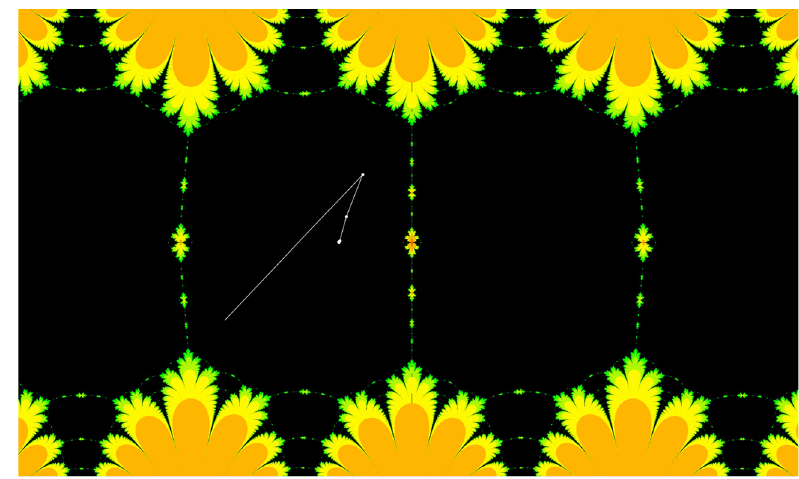
Figure 12: The Fatou set in black, the Julia set in yellow and the orbit of a point in the attracting domain in